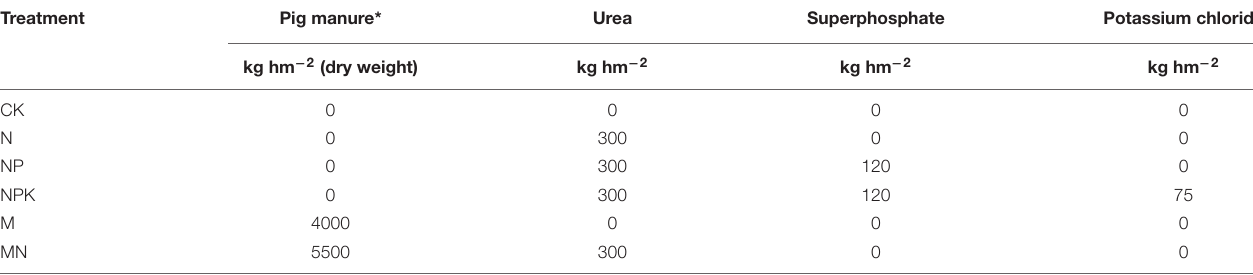
TABLE 1 | Annual input rates of manure and chemical fertilizers in the different treatments. Treatment Pig manure* Urea Superphosphate Potassium